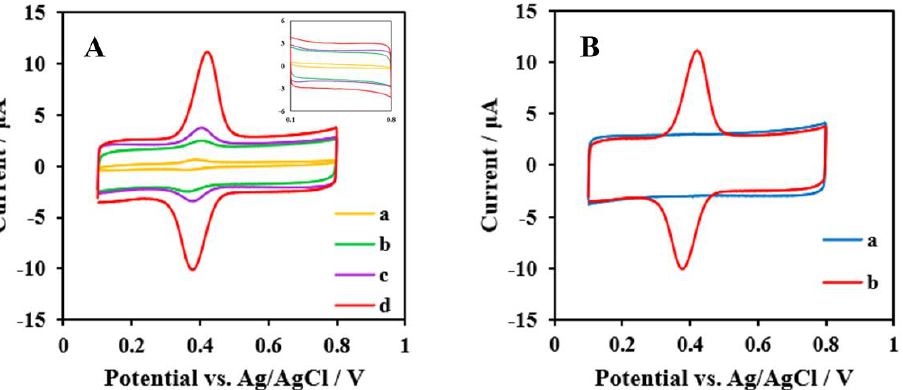
Figure 3. ( A ) CVs of different modified GCEs in 50 mM pH 5 PBS containing 5 µ M rutin at a scan rate of 100 mV ꞏ s −1 . Inset: CVs of different modified electrodes in the absence of rutin. (a) Bare GCE; (b) NF/MWCNTs/GCE; (c) NF/CMC-MWCNTs/GCE; (d) NF/IL/CMC-MWCNTs/GCE. ( B ) CVs of NF/IL/CMC-MWCNTs/GCE in 50 mM pH 5 PBS in the absence (a) and presence (b) of 5 µ M rutin.